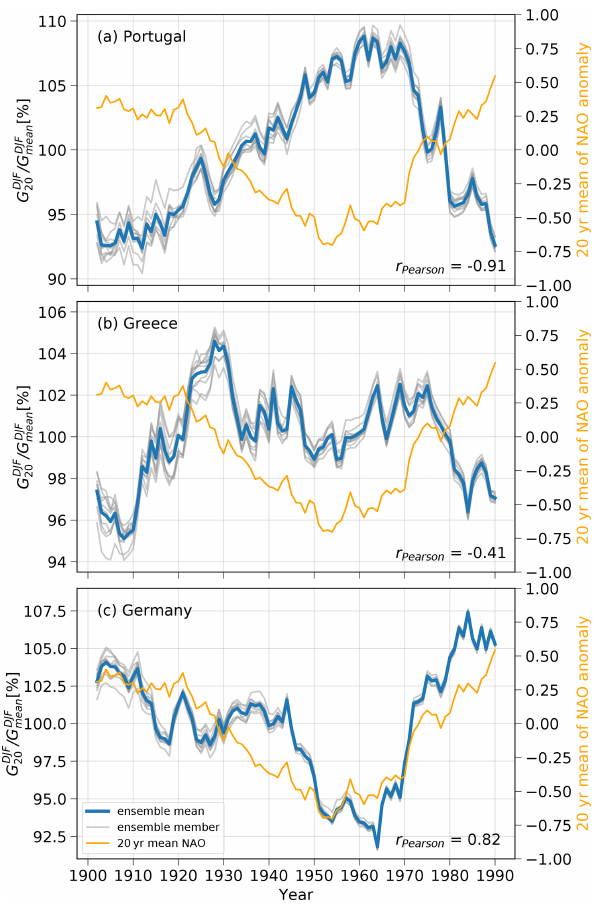
Figure 6. Pairwise combination of 20year running mean of three locations. The corresponding location of the 20year running mean (dashed blue and yellow) is given in the legend of each panel. The variance of their combined 20year running mean G tot (green) is minimized in (a) by λ opt = 0 . 42, in (b) by λ opt = 0 . 39 and in (c) by λ opt = 0 .